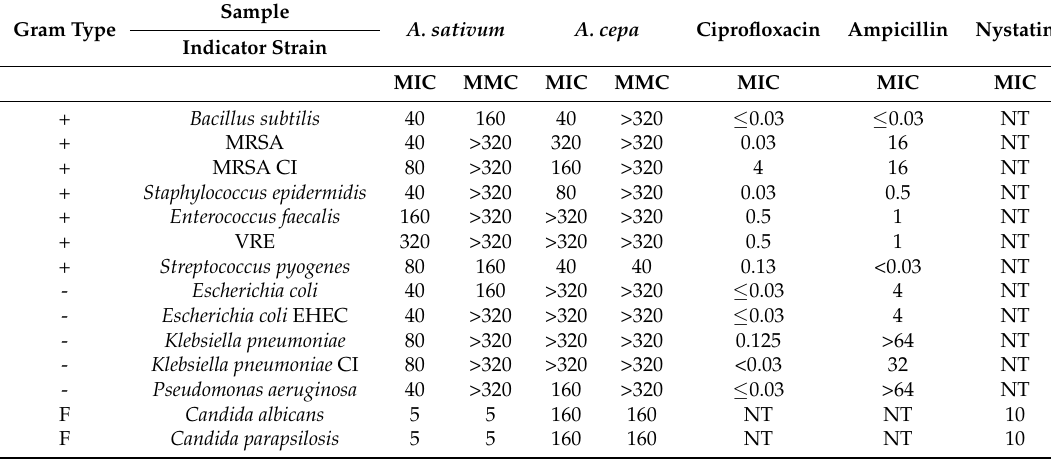
Table 4. Antimicrobial activity of Allium sativum and Allium cepa extracts against different G-positive, G-negative bacteria and Candida yeasts in microdilution assays. Data are given in μ g/mL of minimal inhibitory concentration (MIC) and minimal microbicidal concentration (MMC) values. Positive controls were ciprofloxacin, ampicillin and nystatin; NT: not tested. Sample Gram Type